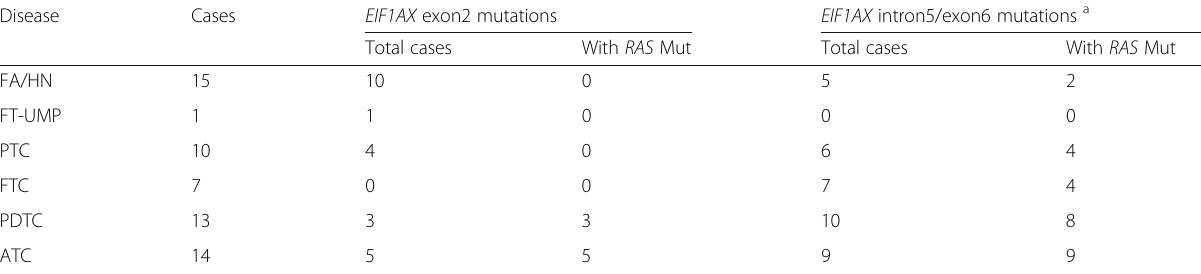
Table 2 EIF1AX mutations were summarized based on our results, COSMIC database, cBioPortal for cancer genomics database and previous studies (references14 – 15, 23 – 27) Disease